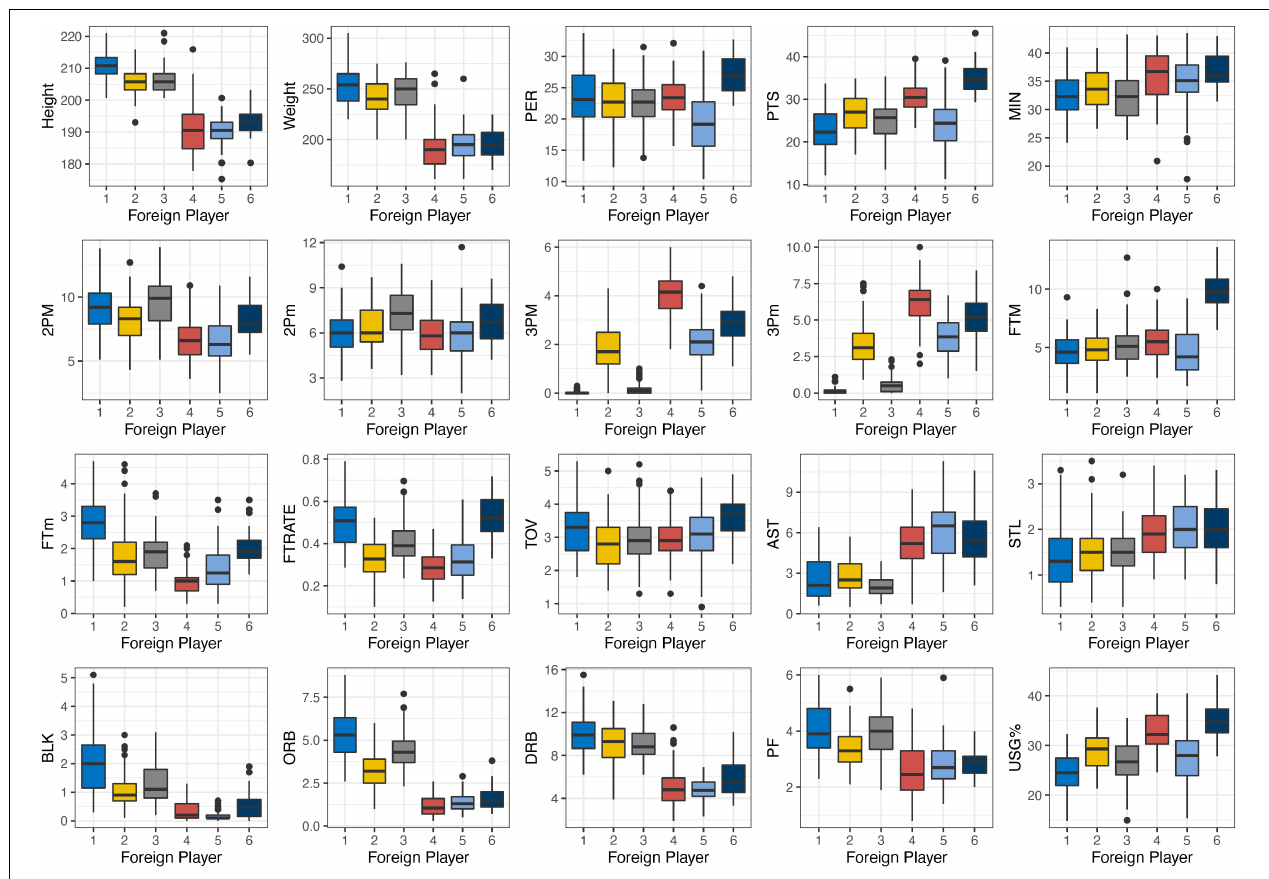
FIGURE 2 | Descriptive statistics of different performance profile clusters in foreign